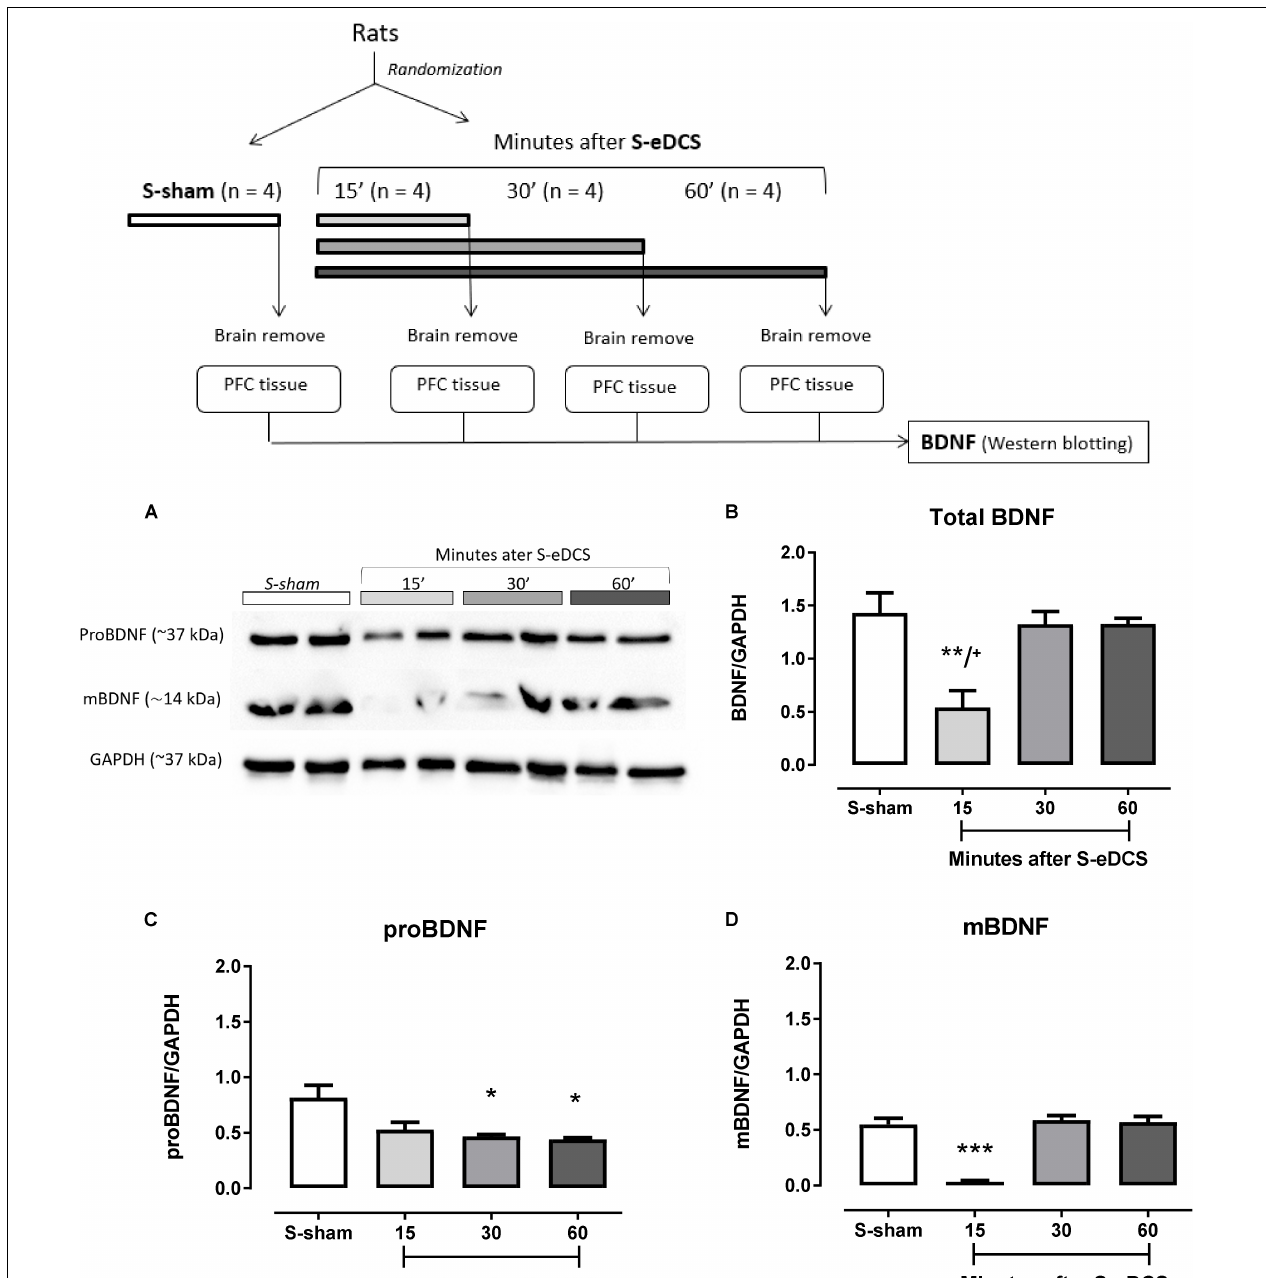
FIGURE 1 | Western blot analysis of brain-derived neurotrophic factor (BDNF) in the prefrontal cortex (PFC) 15 ( n = 4), 30 ( n = 4) or 60 ( n = 4) minutes after a single session of epidural direct current stimulation (S-eDCS) at 400 µ A current intensity during 11 min through a 5-mm round electrode implanted over the left medial Prefrontal Cortex (mPFC) or sham procedure (S-sham). A diagram of general procedures is shown at the top. (A) Bands of the immunoreactivity related to the migration of the proBDNF and mBDNF shown in two animals – biological replicate – from each group. Densitometry analysis: (B) Total BDNF (intensity of proBDNF plus mBDNF), (C) proBDNF, and, (D) mBDNF. Densitometry analyses were normalized to GAPDH and values are presented as the mean ± SEM. ∗ p < 0.05, ∗∗ p < 0.01 when compared to sham control; ∗∗∗ p < 0.001 when compared to sham and to 30 and 60 min; + p < 0.05 when compared to 30 and 60 min (Bonferroni’s multiple comparisons test). Randomization: animals were distributed in groups by computer-generated randomization sequence.